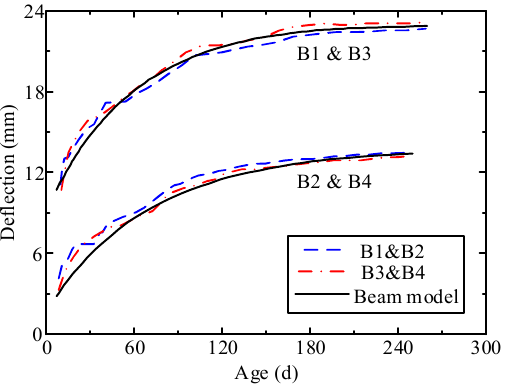
Figure 8. The experimental results in [39] and the prediction results of the finite beam element model (Adapted with permission from Ref. [35]. Copyright 2017 Elsevier.).